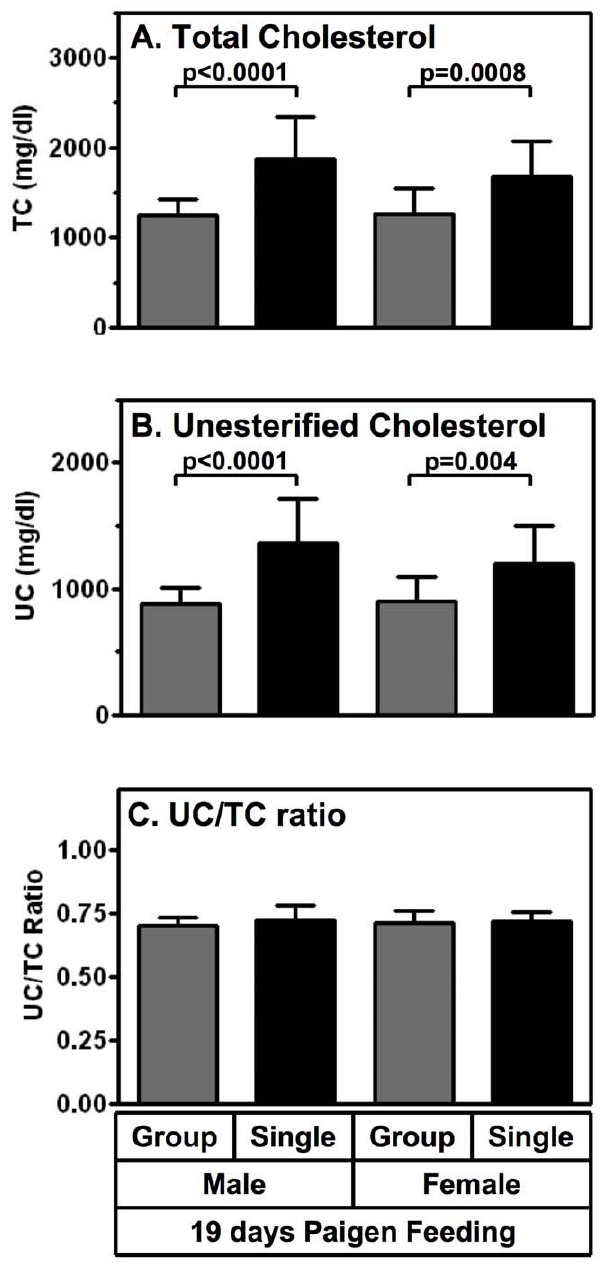
Figure 5. Effects of population density and sex on plasma cholesterol levels of Paigen diet-fed HypoE mice. HypoE mice were housed singly (1/cage, black bars; males, n=16, females; n=13) or in mixed genotype groups (HypoE and one or more SRBI + / 2 ApoeR61 h/h littermates per group, 4–5/cage, gray bars; males, n=19, females; n=24). Beginning at two months of age the animals were switched from a normal chow diet to the Paigen diet. After 19 days of Paigen diet feeding, plasma was harvested and total cholesterol (TC), unesterified cholesterol (UC) and UC/TC ratios were determined from the HypoE mice. Data are means 6 SD. Statistically significant differences were determined by unpaired Student’s t or Mann-Whitney test.